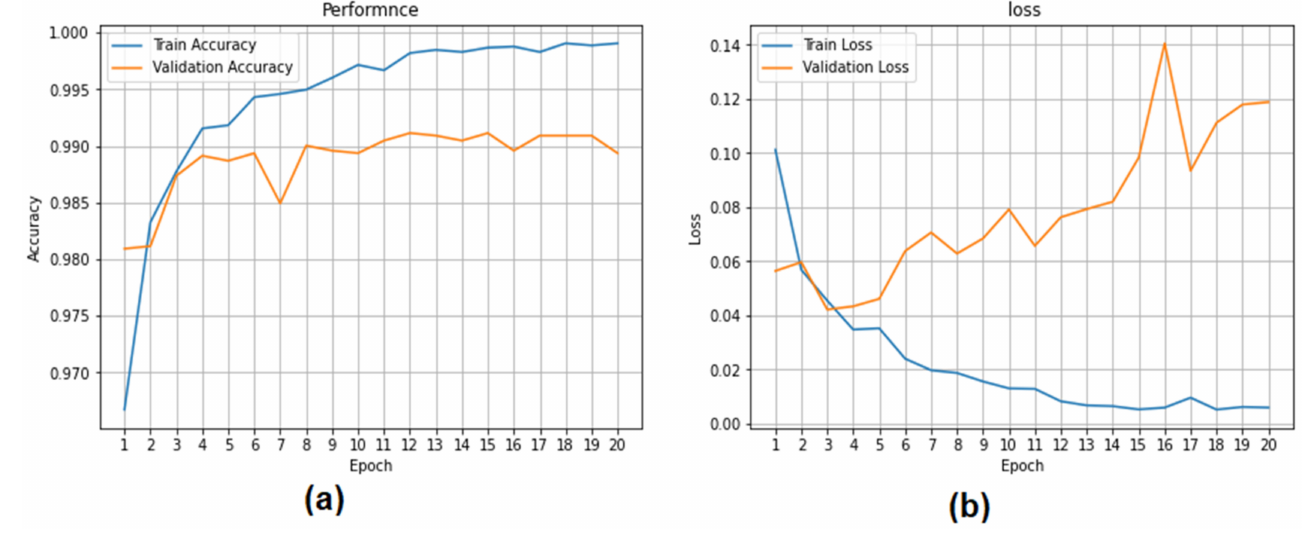
Figure 11. Performance of the CNN-LSTM model in terms of ( a ) accuracy and ( b ) loss. In addition, the mean absolute error statistical analysis (MAE), the mean squared error statistical analysis (MSE), the root mean squared error statistical analysis (RMSE), and the R 2 were utilized in order to calculate the percentage error that existed between the target values and the predictions. The statistical analysis of ML and DL using binary classification is broken down and summarized in Table 8. According to the results of the CNN-LSTM model, the correlation between the target and the prediction values was the maximum it could be (R 2 = 98.42%), and the prediction error MSE =